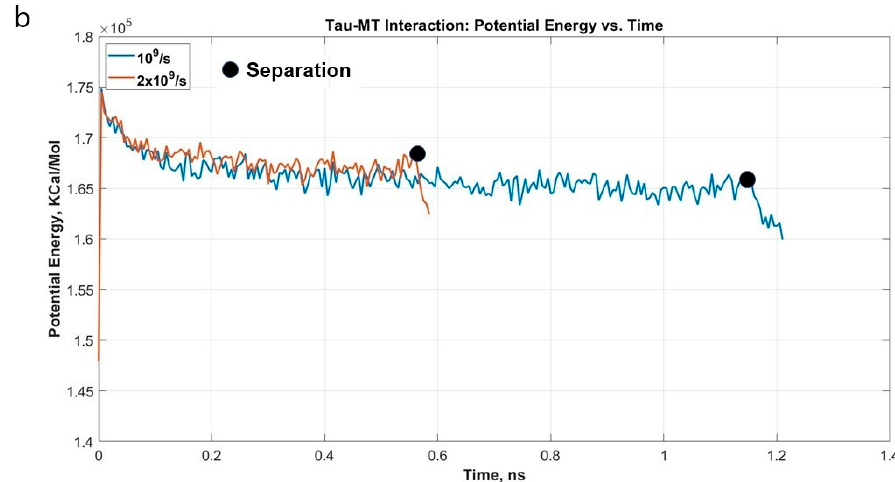
Figure 5. ( a ) Stress vs. Strain graph for the projection domain of tau during the pulling at different strain rates. The stress-strain trends are similar for both the strain rates, although the separation occurs at different strains. ( b ) Potential energy vs. time plot for the single tau-MT system.